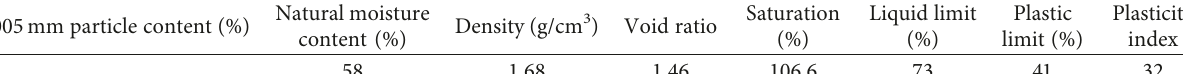
Table 1: Physical parameters of red clay.